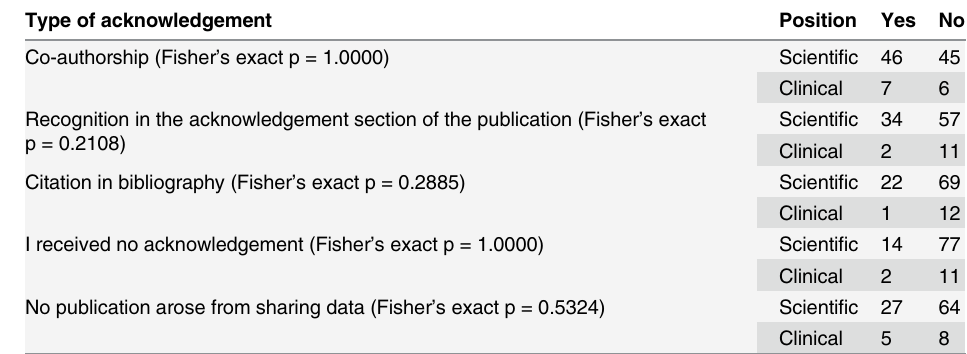
Table 15. Scientific group vs. Clinical group: type of acknowledgement of data